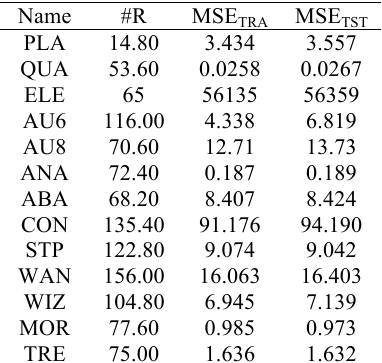
Table 2 Initial Results using WM rule base